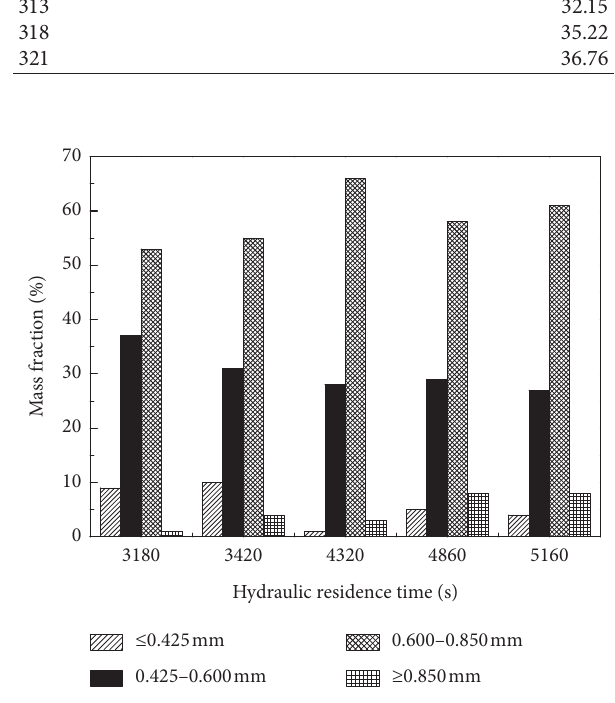
Figure 11: Effect of different hydraulic residence times on crystal size distribution. Table 5: C.V. of the product with different hydraulic residence